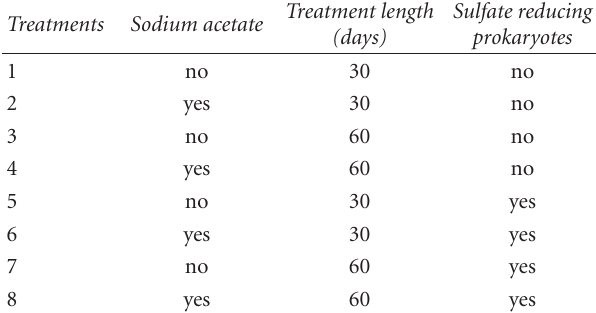
Table 2: Operating conditions in the anaerobic pretreatments (Table 1 shows factors and